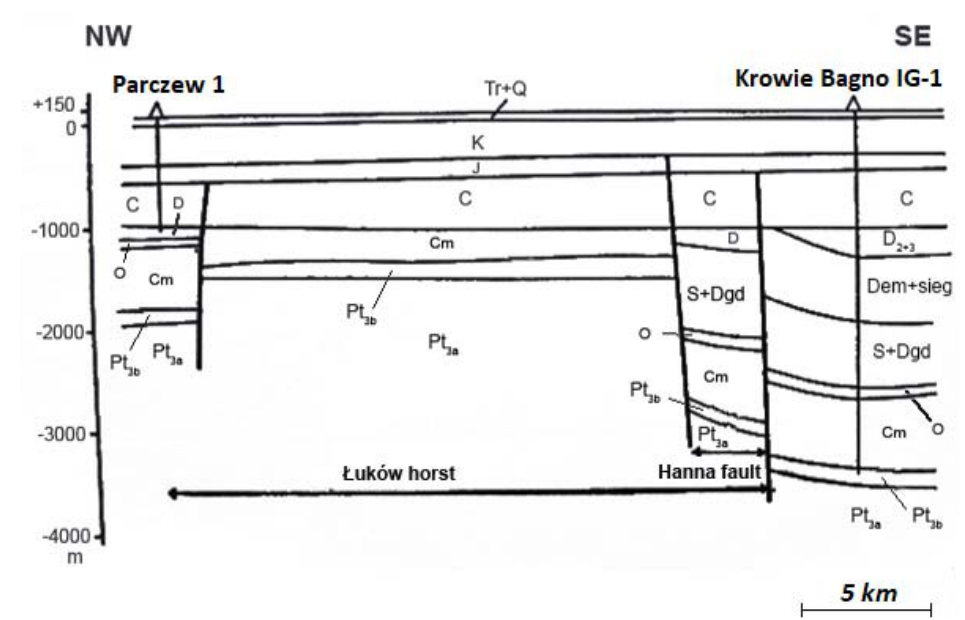
Figure 1. Geological cross-section (AA’ on Figure 3) of the Hanna fault (according to [19]; Pt 3a —Upper Proterozoic (crystalline rocks); Pt 3b —Lower Proterozoic; Cm—Cambrian; O—Ordovician; S—Silurian; D—Devonian; Dgd—Lower Devonian, marine facies of Gedinnian and Siegenian; sieg—Siegenian; Dem + sieg—Lower Devonian, old red facies of Siegenian and Emsian; D 2+3 —Mid and Upper Devonian; C—Carboniferous; Tr + Q—Triassic and tertiary; J—Jurassic; K—Cretaceous.